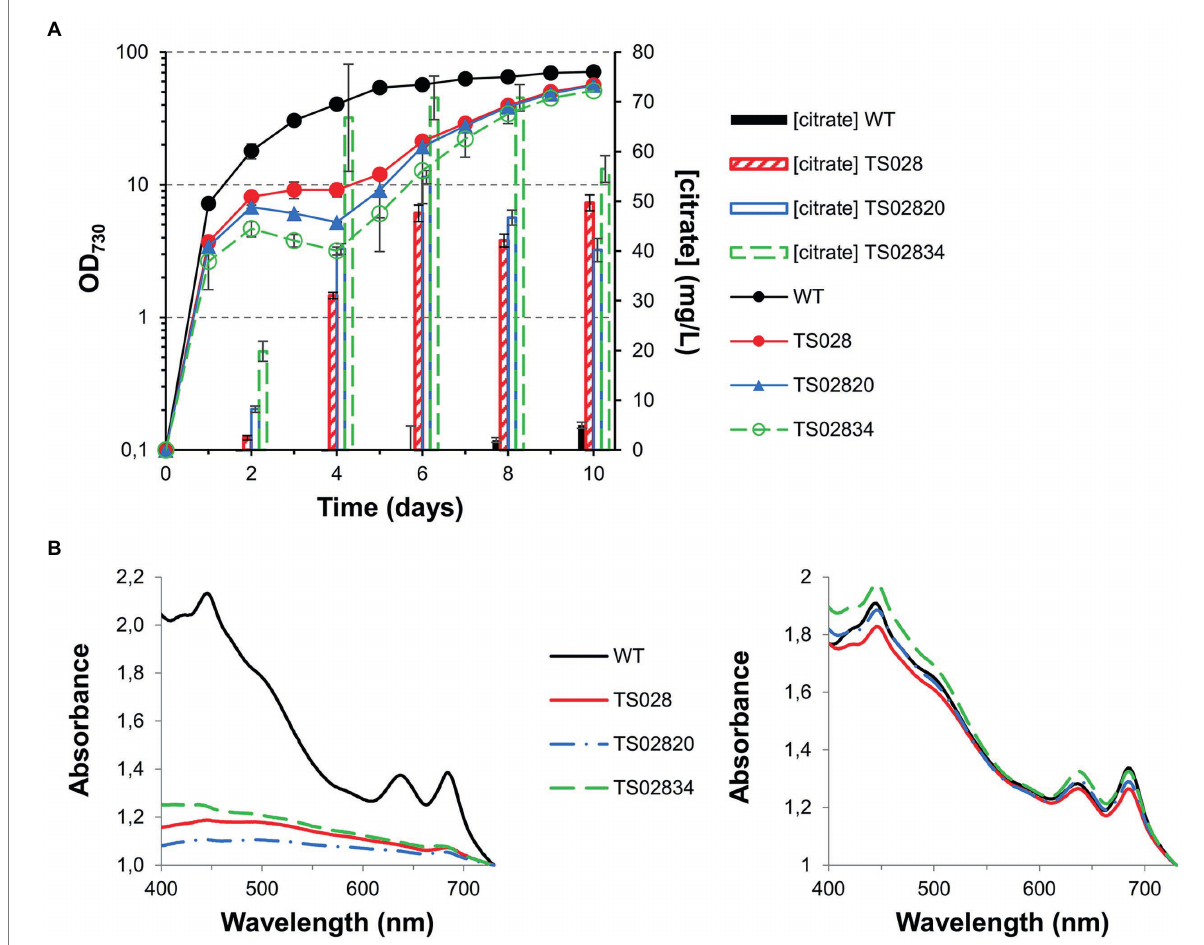
FIGURE 6 Growth curves, citrate quantification and whole cell spectra (in MAD, 1.5% CO 2 , high light) for first, second and third generation strains with acnB gene control. (A) Growth curves and citrate quantification. (B) Whole cell spectra at day 3 (left) and day 8